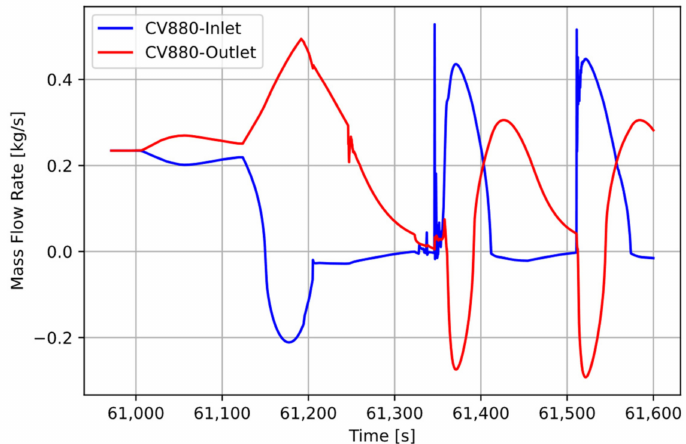
Figure 11. Flow mass rate at the liner floor cooling volume inlet/outlet.